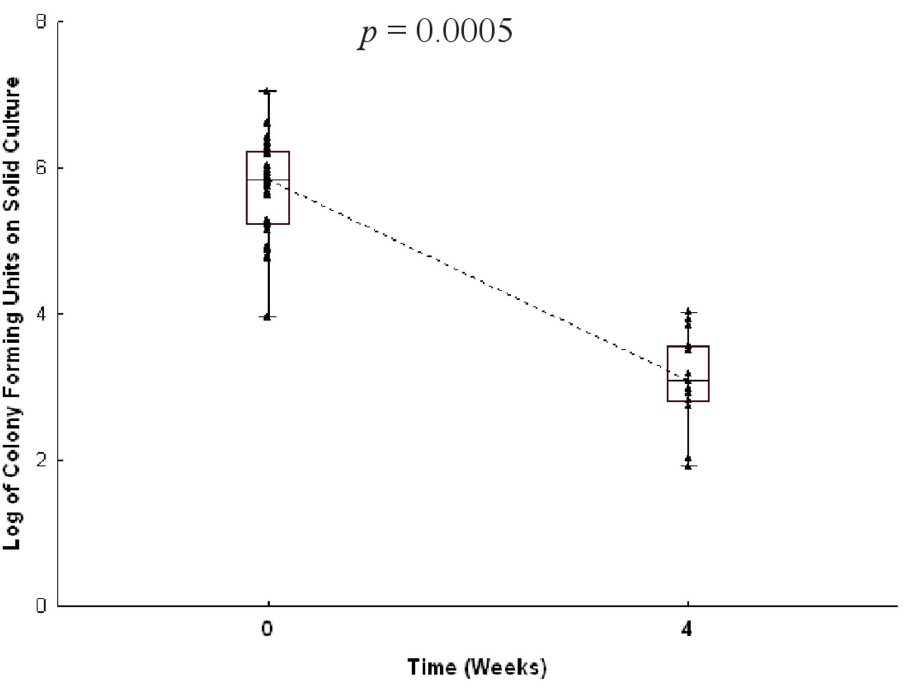
Figure 5. Quantitative cultures and treatment duration. Quantitative cultures from subjects with smear positive pulmonary TB as shown by the log of colony forming units (CFU) enumerated on 7H10 media at week 0 (n=35) and week 4 (n=14). Raw data, shown as a triangle, surrounded by the box demonstrates the distribution of 25–75% of the data, with the whiskers representing the non-outlier data, and the horizontal line depicting the median. The dotted line connects the median points. Wilcoxon signed rank test was performed comparing subjects with week 0 and week 4 (n=12).